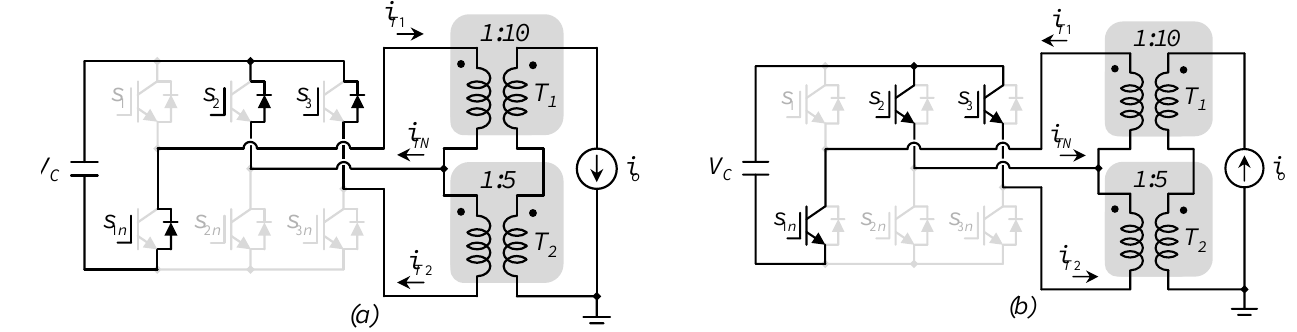
Figure 11. Current flow for different directions of the load current when s 1 = 0, s 2 = 1, and s 3 = 1. (a) when the load current is positive and (b) when the load current is negative. 2.5. The State {1, 0, 0}